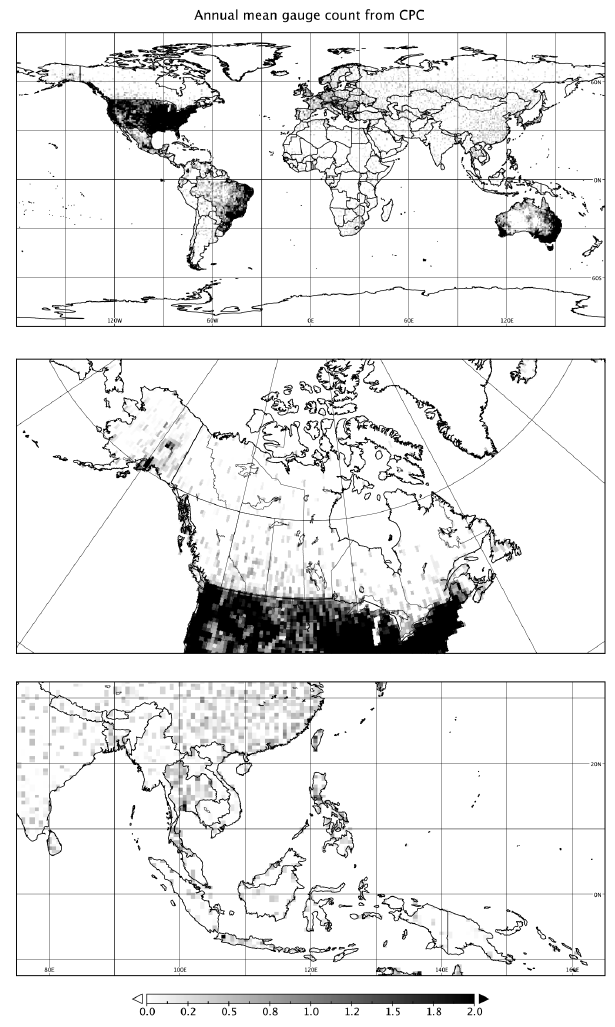
Figure 10. Mean 1979–2012 CPC rain gauge coverage (gauges/grid cell) for the globe (top), Canada (middle), Southeast Asia (bottom). to year. This information is provided as part of the data